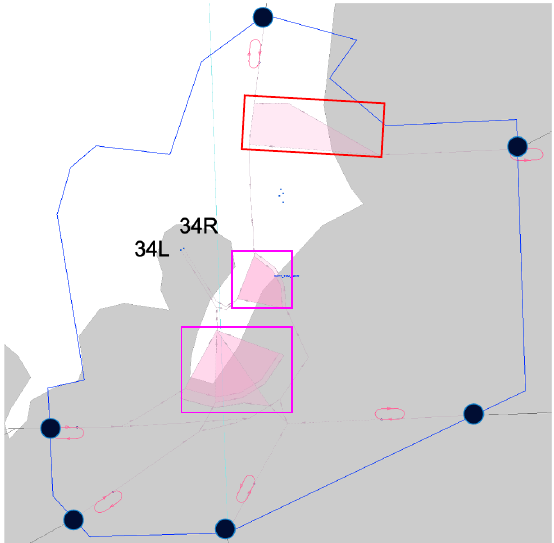
Figure 13. TACA (blue polygon) and two runways (34L and 34R) at RJTT. Vectoring zones are composed of an red rectangle (radar vector) and pink rectangle (point-merge system). The traffic volumes in TACA and in-trail separation at entry fixes are assumed in the